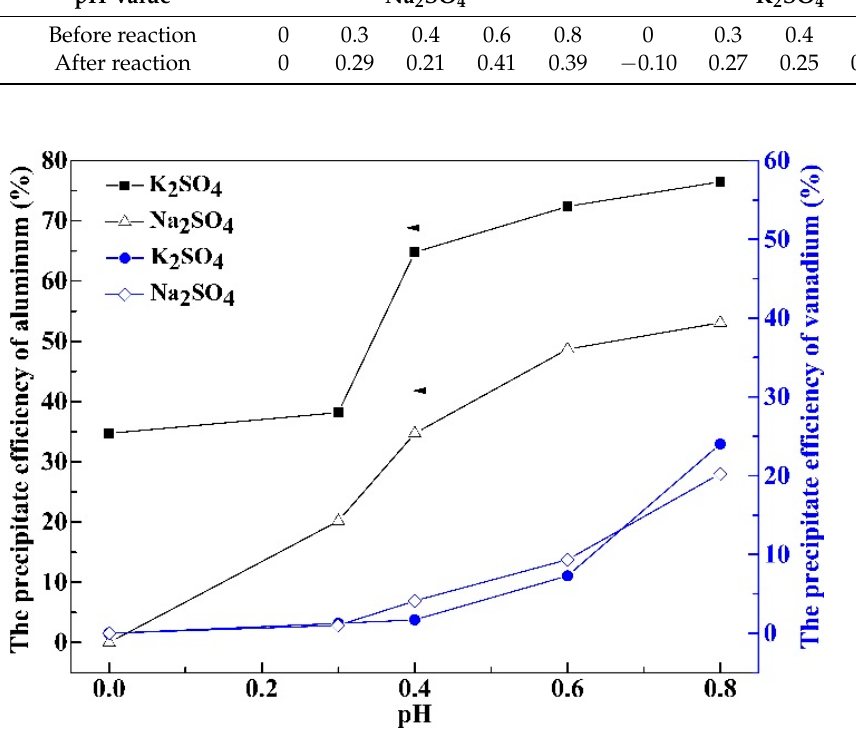
Figure 1. Effect of pH value on the precipitation efficiency of aluminum and vanadium.